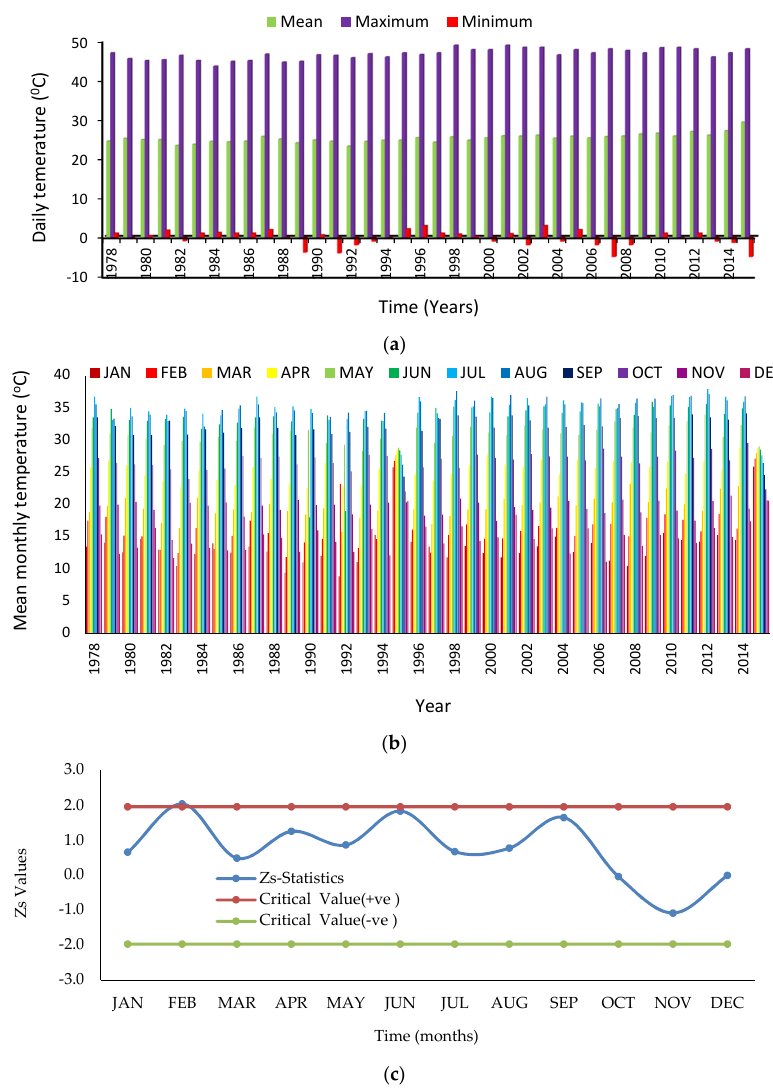
Figure 3. Mean temperature (observed data) for the Qassim region: ( a ) mean, maximum and minimum temperature; ( b ) mean monthly temperature; and ( c ) trend analysis for temperature